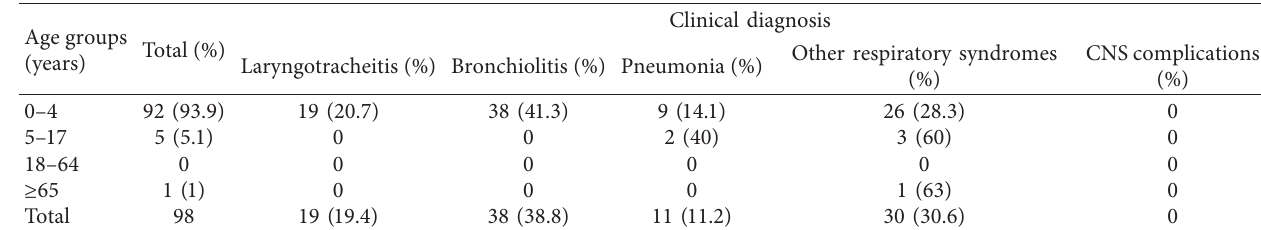
Table 2: Clinical diagnosis among the hBoV-infected patients according to age.